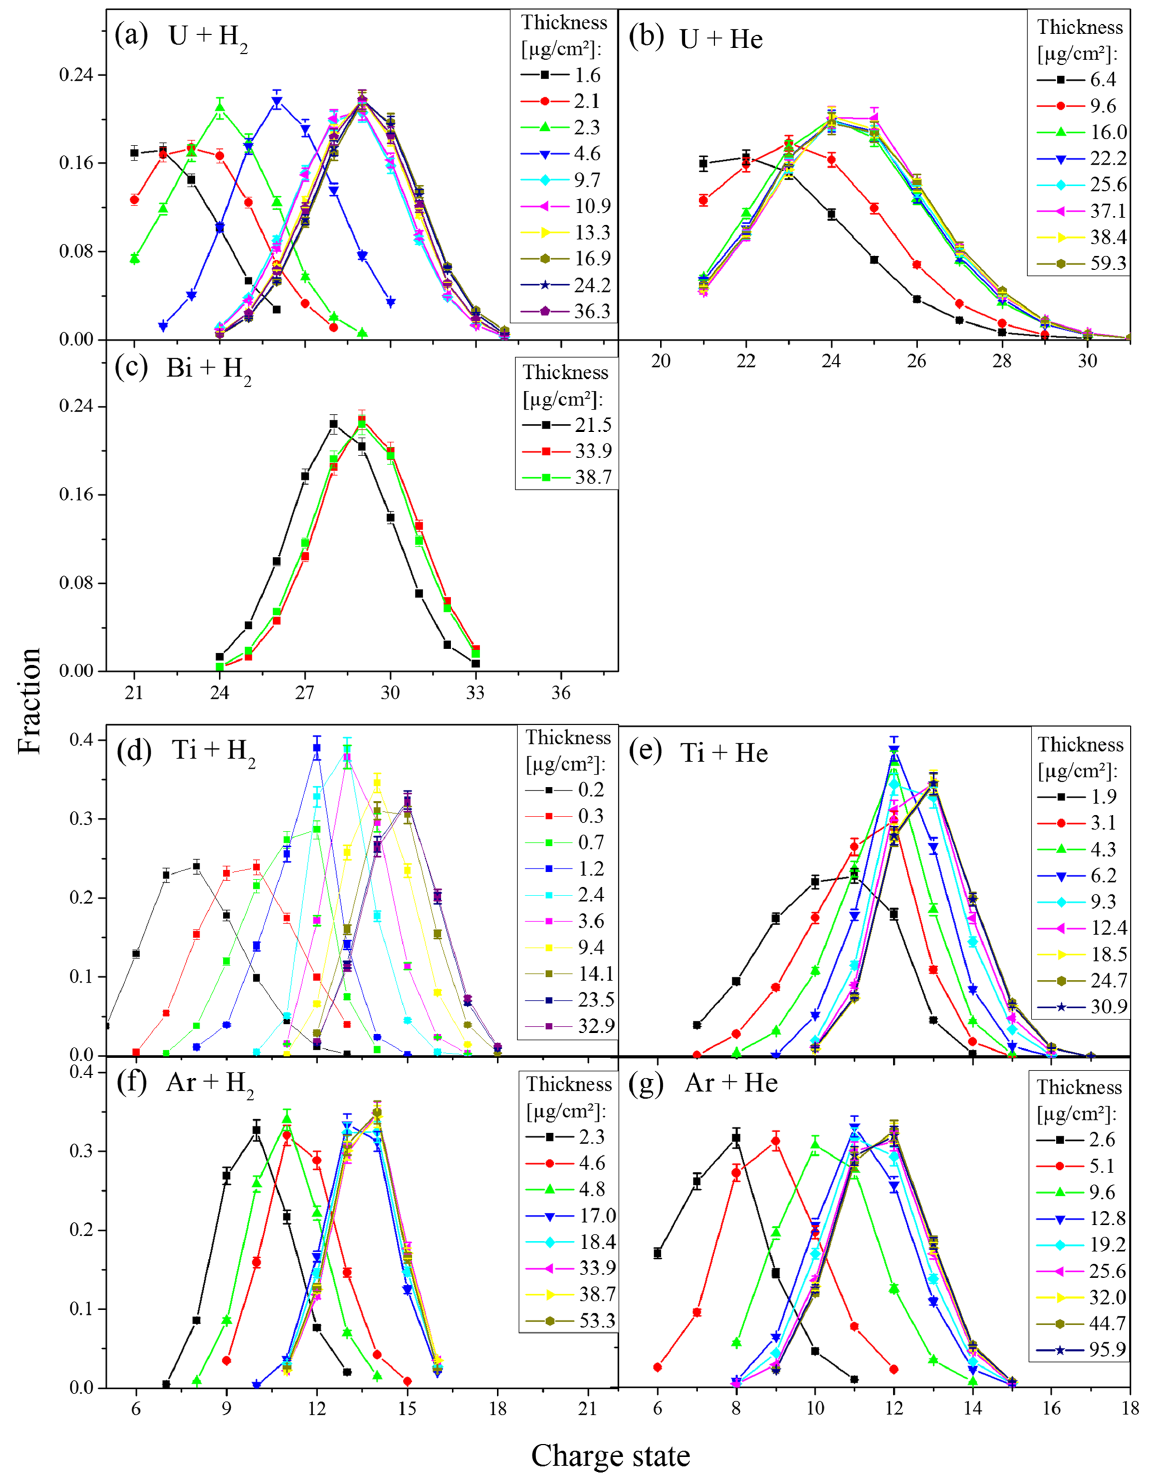
FIG. 5. Charge state distributions of 238 U, 209 Bi, 50 Ti, and 40 Ar ion beams at 1 . 4 MeV = u after passing through H 2 and He gas for various target thicknesses. The lines are added to guide the